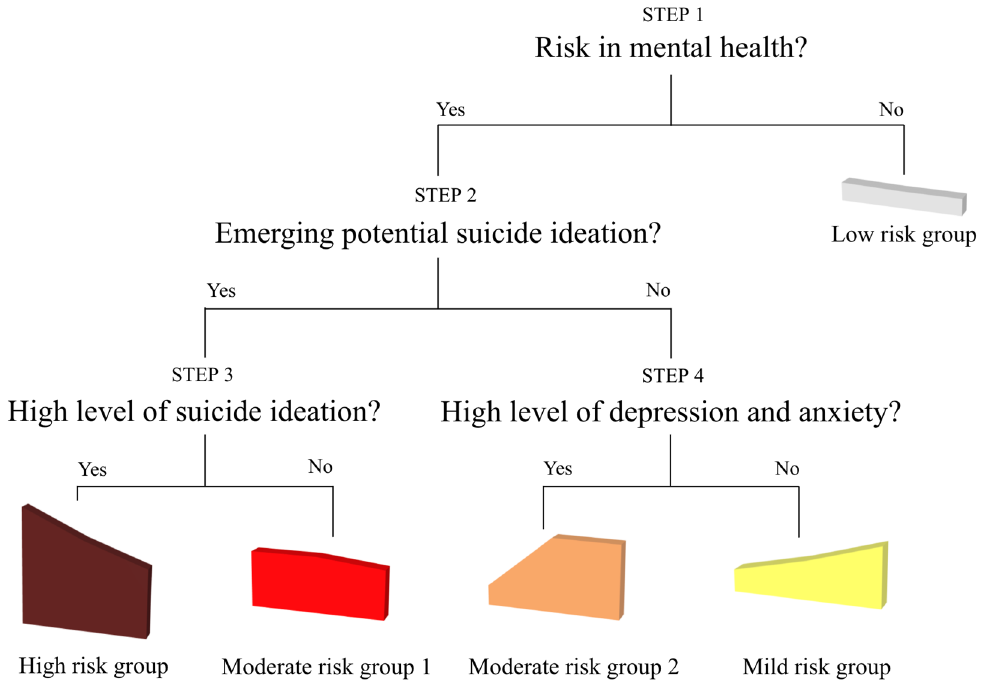
Figure 4. Screening steps across the latent profiles of female